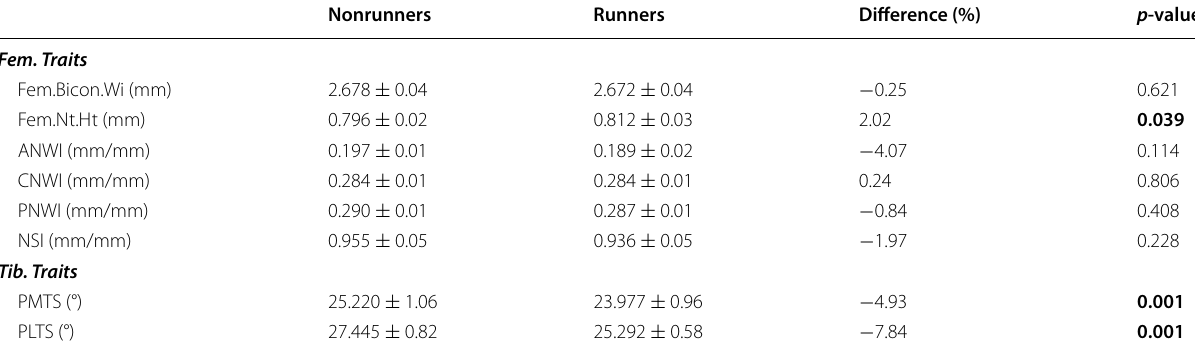
Table 5 Least square mean differences in knee morphology measures between B6 runners and